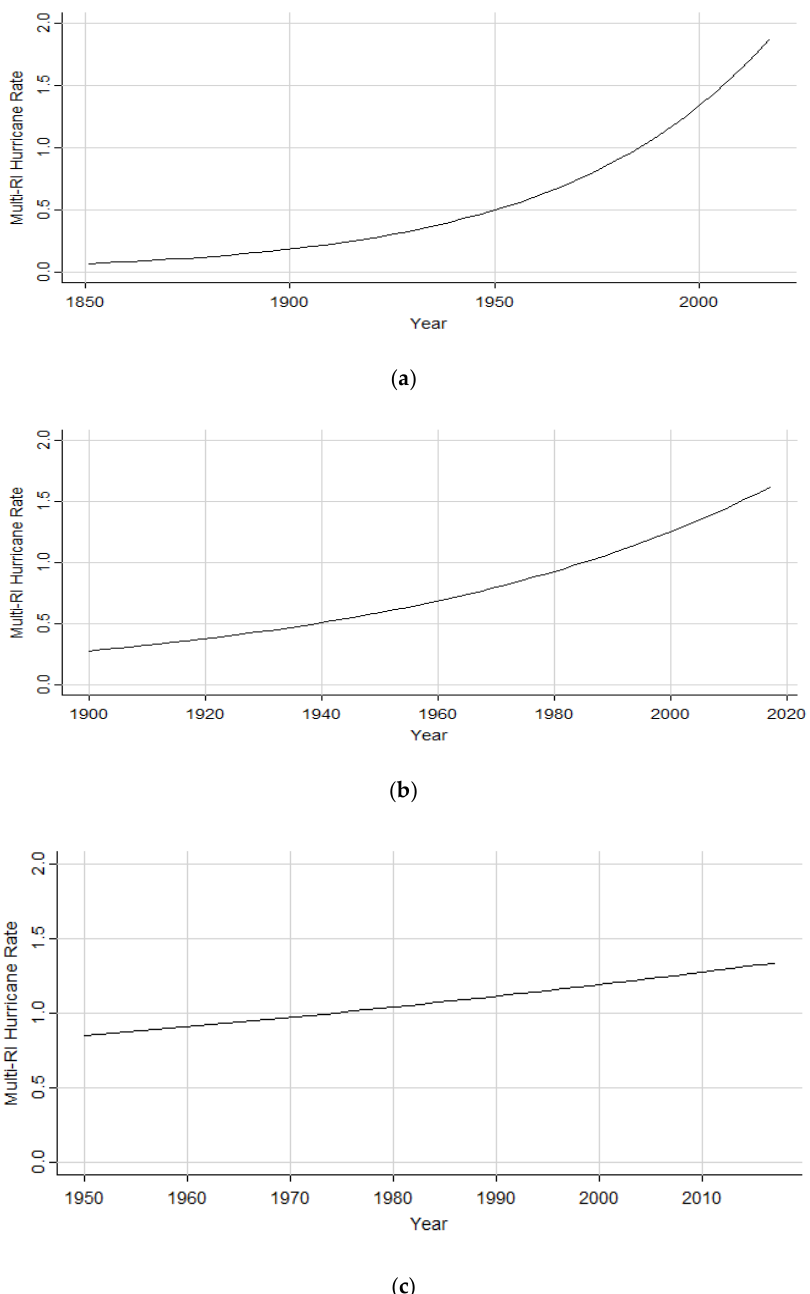
Figure 6. Incidence rate ratio showing ( a ) a 2% increase of hurricanes undergoing more than one cycle of RI in their lifetimes from 1851 – 2017, ( b ) a 1.5% increase of hurricanes undergoing more than one cycle of RI from 1900 – 2017, and ( c ) a 0.7% increase of hurricanes undergoing more than one cycle of RI from